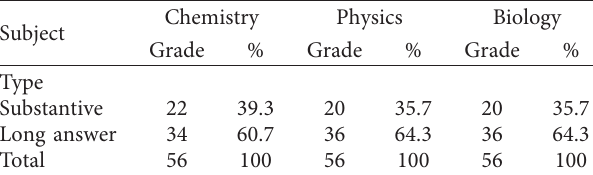
Table 7: Final examinations’ grade distribution for chemistry, physics, and biology based on type.